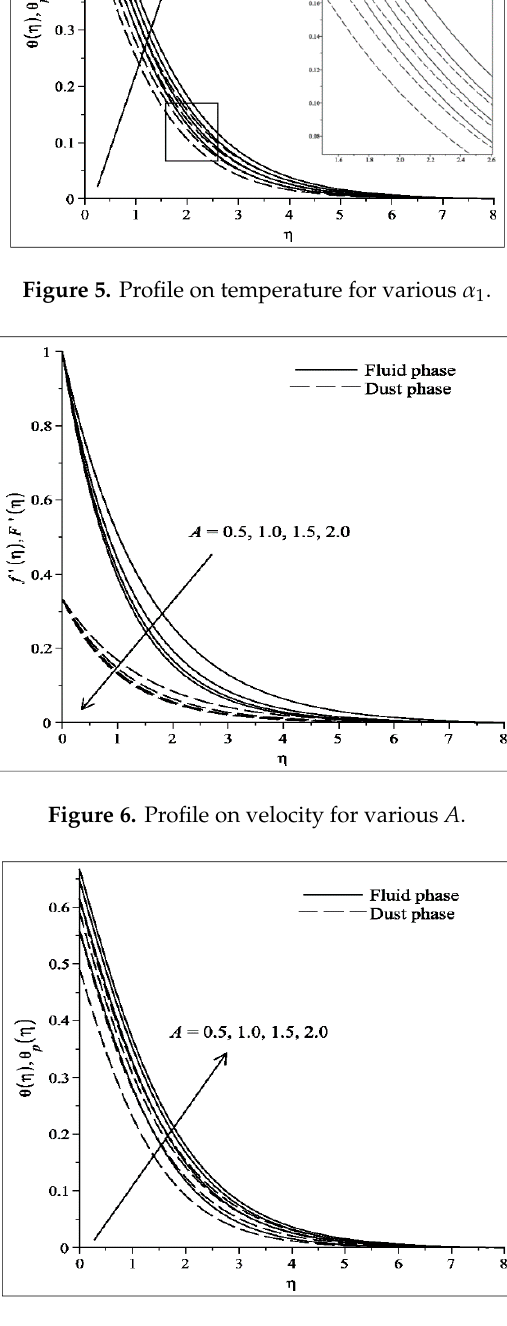
Figure 7. Profile on temperature for various .